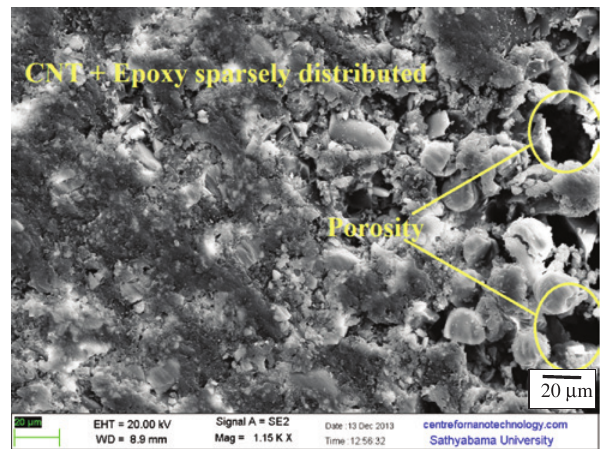
Figure 13: GFRP with CNTs 3% before